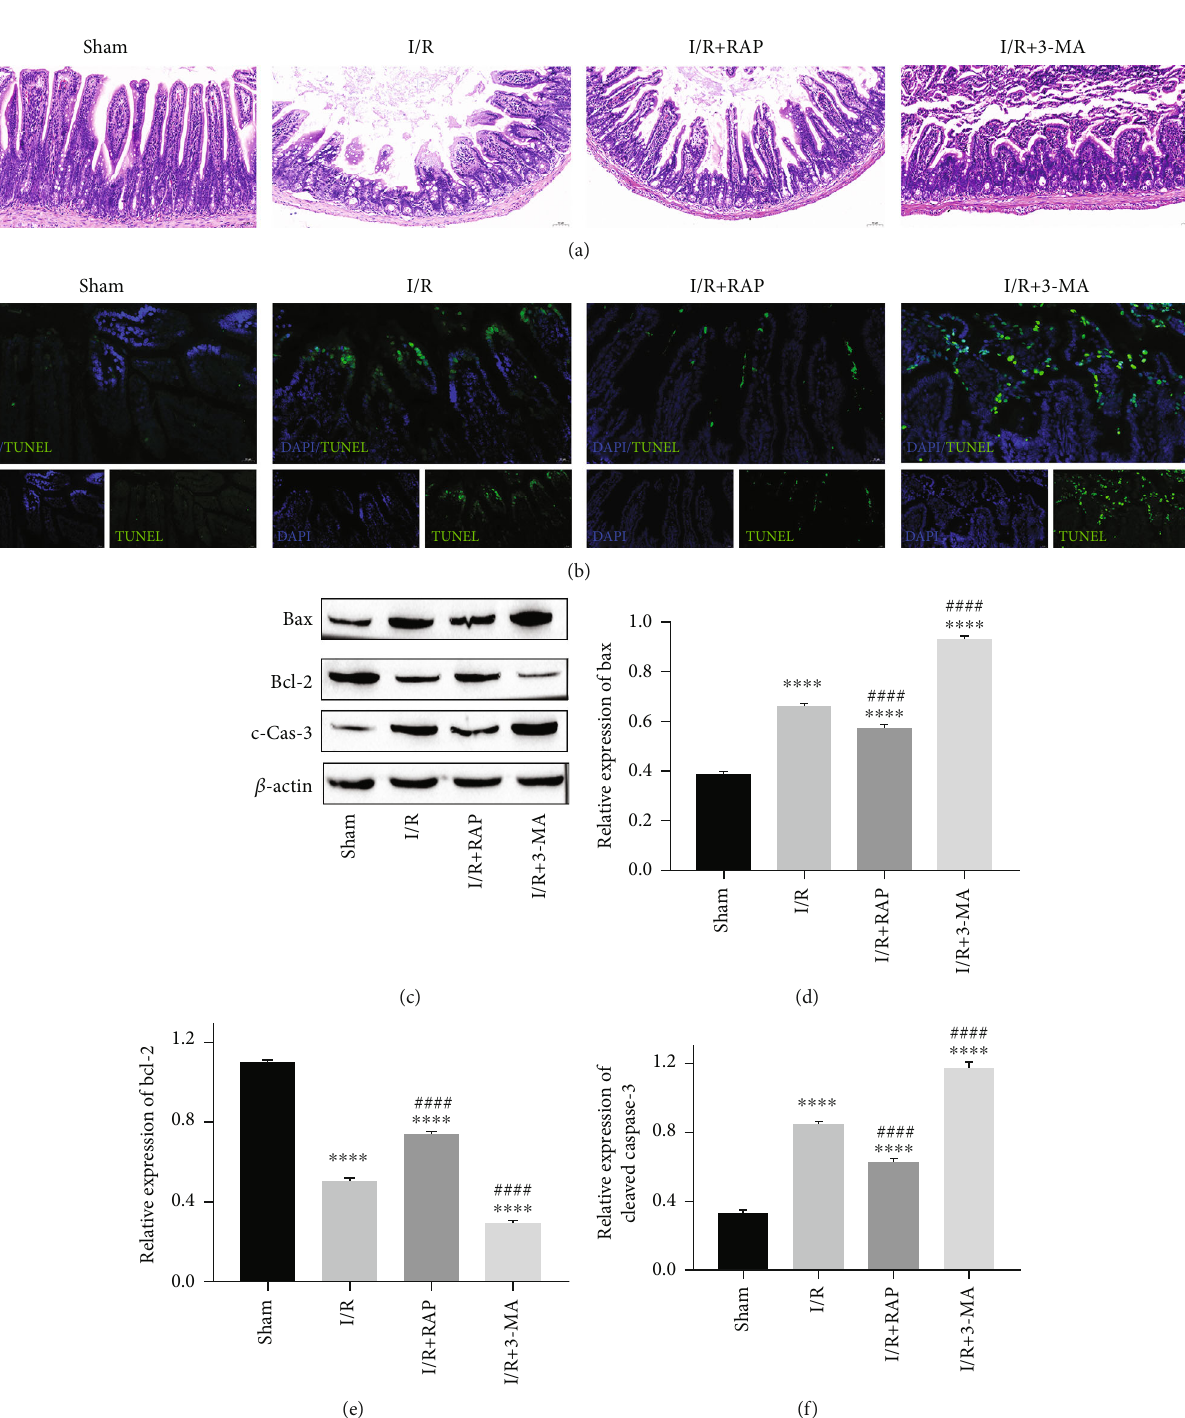
Figure 3: The e ff ects of 3-MA and RAP on intestinal epithelial apoptosis after IRI. (a) Representative images of H&E staining of intestinal tissues in each group. (b) Representative images of intestinal epithelial apoptosis detected by TUNEL activity. (c) The representative bands of Western blotting. (d – f) The expression of Bax, Bcl-2, and cleaved caspase-3. ∗ P < 0 : 05 , ∗∗∗ P < 0 : 001 , and ∗∗∗∗ P < 0 : 0001 vs. sham group; # P < 0 : 05 , and #### P < 0 : 0001 vs. I/R group. n = 5 per group in the sham and I/R groups, and n = 10 per group in the other